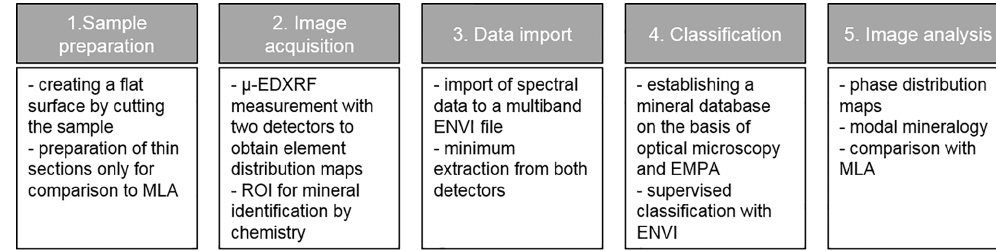
Figure 2. Block scheme for the workflow of the µ-EDXRF analysis.